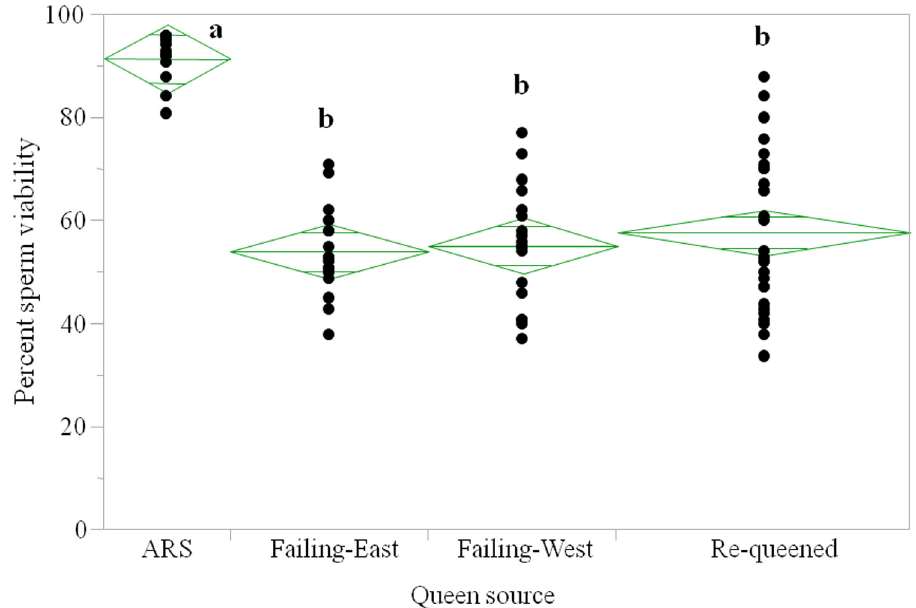
Fig 1. Sperm viability in honey bee queens removed from four different geographic locations; colonies managed by USDA-ARS in Maryland were in apparent good health (n = 12 queens), two commercial beekeeping operations where the beekeeper rated the colonies as in failing health (western U.S. n = 18, eastern U.S. n = 19) and a commercial beekeeper in California who removed queens during routine queen replacement without reguard to colony health (requeen n = 28) where most queens were considered to be ca. one year in age. The actual age of all queens is unknown. Letters indicate significant differences between means by queen source (ANOVA, P = 0.0001).